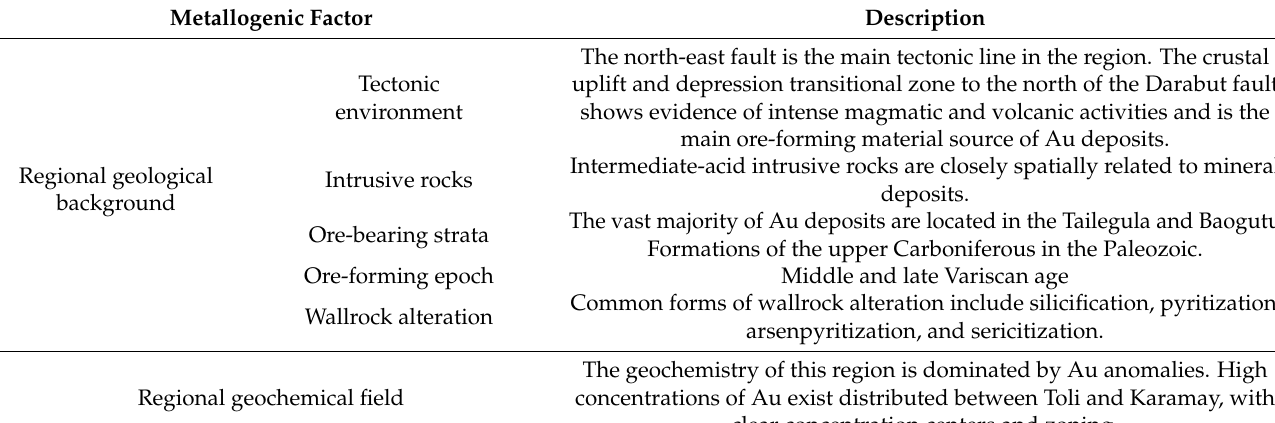
Figure 2. Spatial context of the study area: ( a ) location of Xinjiang in China; ( b ) location of the study area in Xinjiang; ( c ) schematic geological map of the study area (modified after 1:200,000 geological map). Table 2. Conceptual Model of Au Deposits in the Study